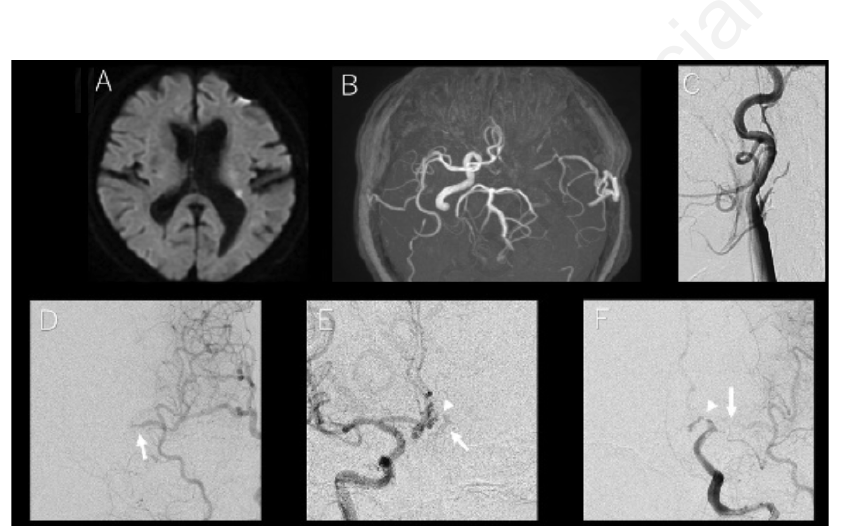
Figure 1. A) Diffusion-weighted imaging on admission shows a spotty, high-intensity lesion in the left corona radiata. B) Magnetic resonance angiography shows a patent superficial temporal artery (STA)-middle cerebral artery (MCA) bypass and MCA occlu- sion. The left A1 portion of the anterior cerebral artery (ACA) is slightly visualized. The left internal carotid and posterior communicating arteries are not visualized. C) Left common carotid artery (CCA) angiography taken immediately following the MR studies shows near-occlusion of the left internal carotid artery (ICA). D) Antero-posterior (AP)- view left external carotid artery (ECA) angiogram shows patency of the STA-MCA bypass and occlusion of the left M1 (white arrow). E) AP-view right ICA angiogram shows slight opacification of the terminal portion of the left ICA (arrow), although the severely stenot- ic left A1 (arrowhead) segment of the left anterior choroidal artery is not clear. F) AP- view left CCA angiogram after successful carotid artery stenting shows better visualiza- tion of the ICA. Stenosis of the A1 (arrowhead) and occlusion of the M1 (arrow) are evi- dent after branching from the anterior temporal